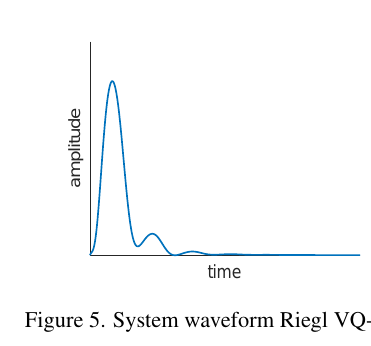
Figure 5. System waveform Riegl VQ-880.